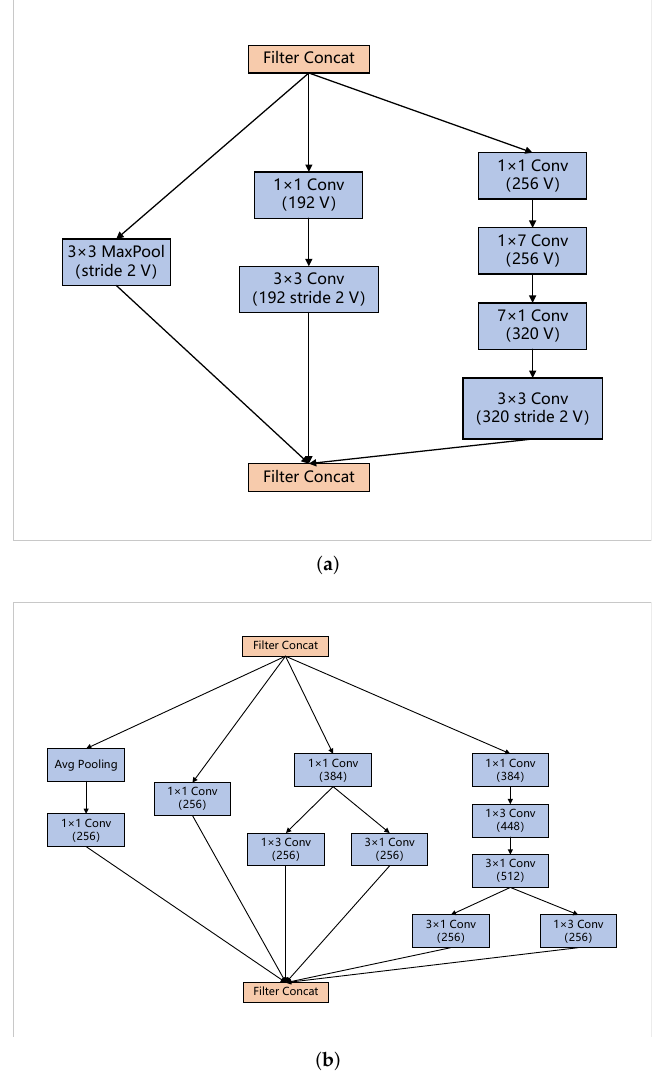
Figure 6. The module structure: ( a ) Reduction_B; ( b )